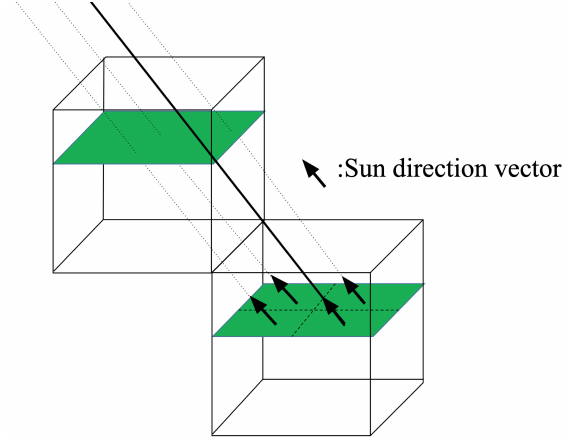
Figure 5. Conceptual diagram of CS computation. CS indicates the fraction of direct solar irradiance that is shielded by other voxels. The plane assumed in the voxel is divided into four equal parts, and a line is generated from each plane towards the sun. The percentage of lines shielded by other voxels is the value of CS. In this method, CS is a discrete value, with a one of 0.00, 0.25, 0.50, 0.75, or 1.00. Dotted lines indicate intersections with other voxels, and bold lines indicate no intersections with